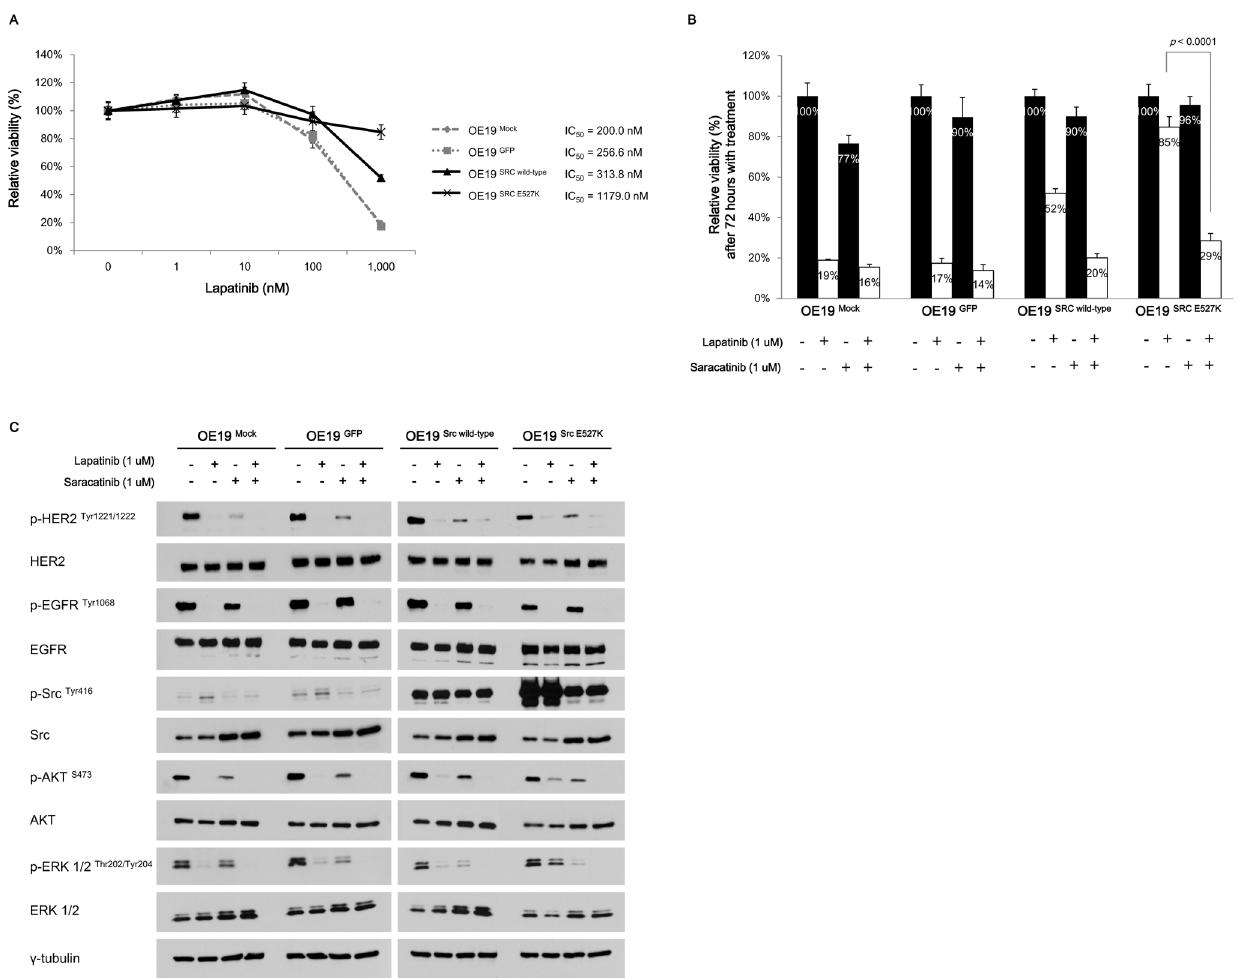
Figure 5. Impact of ectopic expression of Src E527K in parental OE19 on lapatinib sensitivity and cell signalling. A, Dose-response curves for lapatinib in the non-transduced parental OE19 (OE19 Mock ), transduced with GFP (OE19 GFP ), wild-type Src (OE19 Src wild-type ) or Src E527K mutation (OE19 Src E527K ). The calculated values of IC 50 for lapatinib was . 1,000 nM in OE19 Src E527K cells. Values were presented as relative cellular viability relative to vehicle-treated controls with the mean 6 S.E. of quadruplicate from a representative experiment. The p value calculated by two-way ANOVA was 0.376 for mock vs control (GFP), , 0.0001 for control vs wild-type Src, and , 0.0001 for control vs Src E527K . B, Relative cell viability lapatinib in the non-transduced parental OE19 (OE19 Mock ), transduced with GFP (OE19 GFP ), wild-type Src (OE19 Src wild-type ) or Src E527K mutation (OE19 Src E527K ). The p values were calculated by two-tailed t -test. Values were presented as relative cellular viability relative to vehicle-treated controls with the mean 6 S.E. of quadruplicate from a representative experiment. C, Immunoblots showing changes of various signalling proteins after treatment with 1 m M concentration of lapatinib or saracatinib, either alone or combination, in the OE19 cells with or without Src E527K transduction.